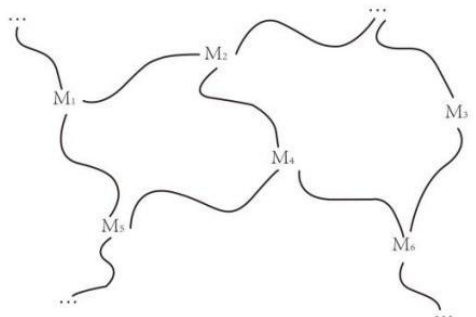
Figure 5. Correlative net.